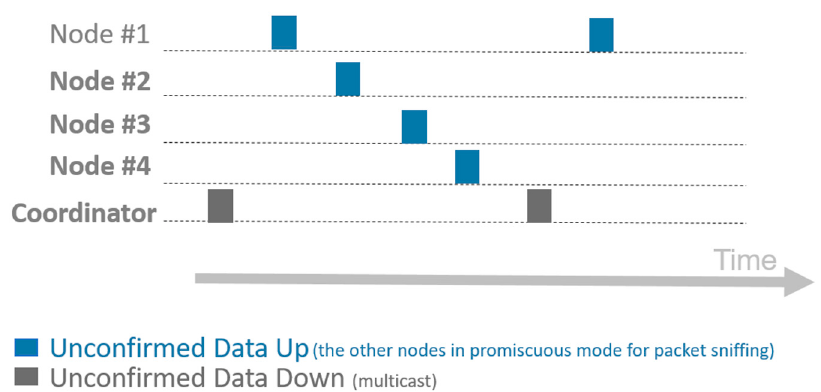
Figure 5. LoRaWAN vs. Short Lora transmission intervals.